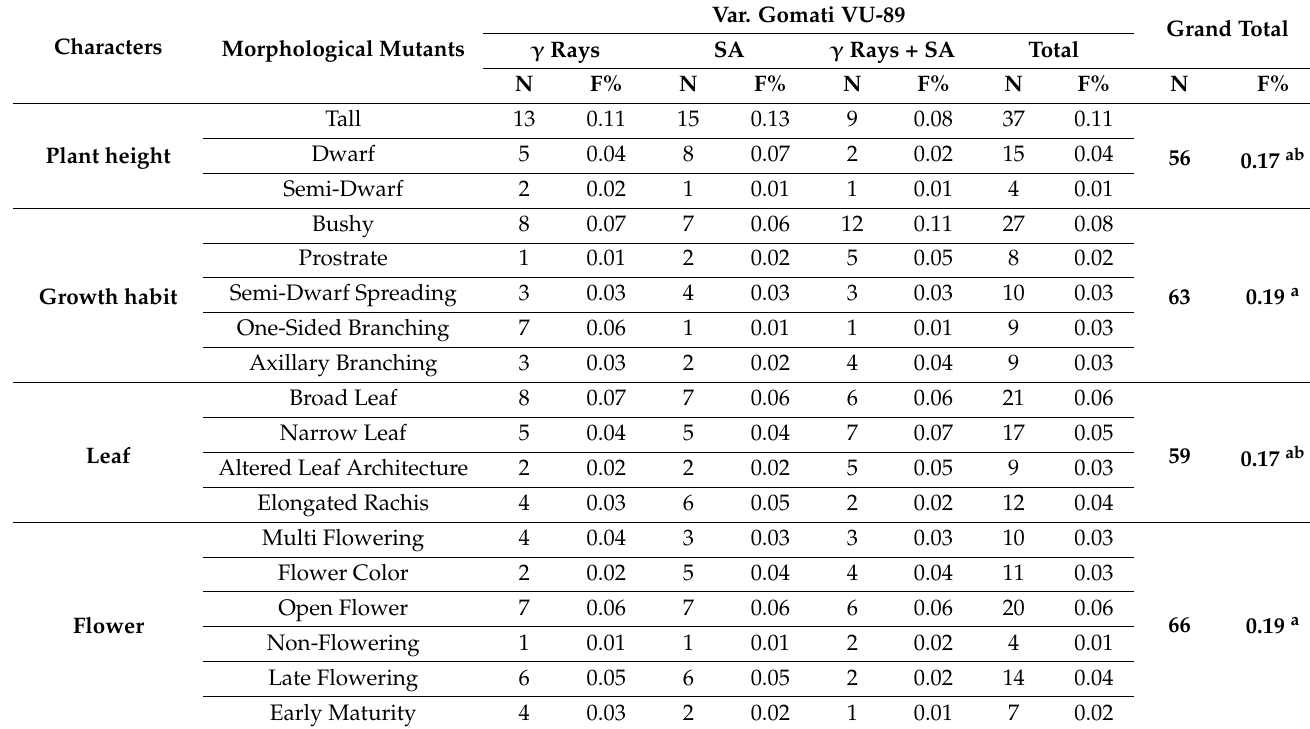
Table 6. Frequency and spectrum of morphological mutants in the M 2 generation of cowpea var. Gomati